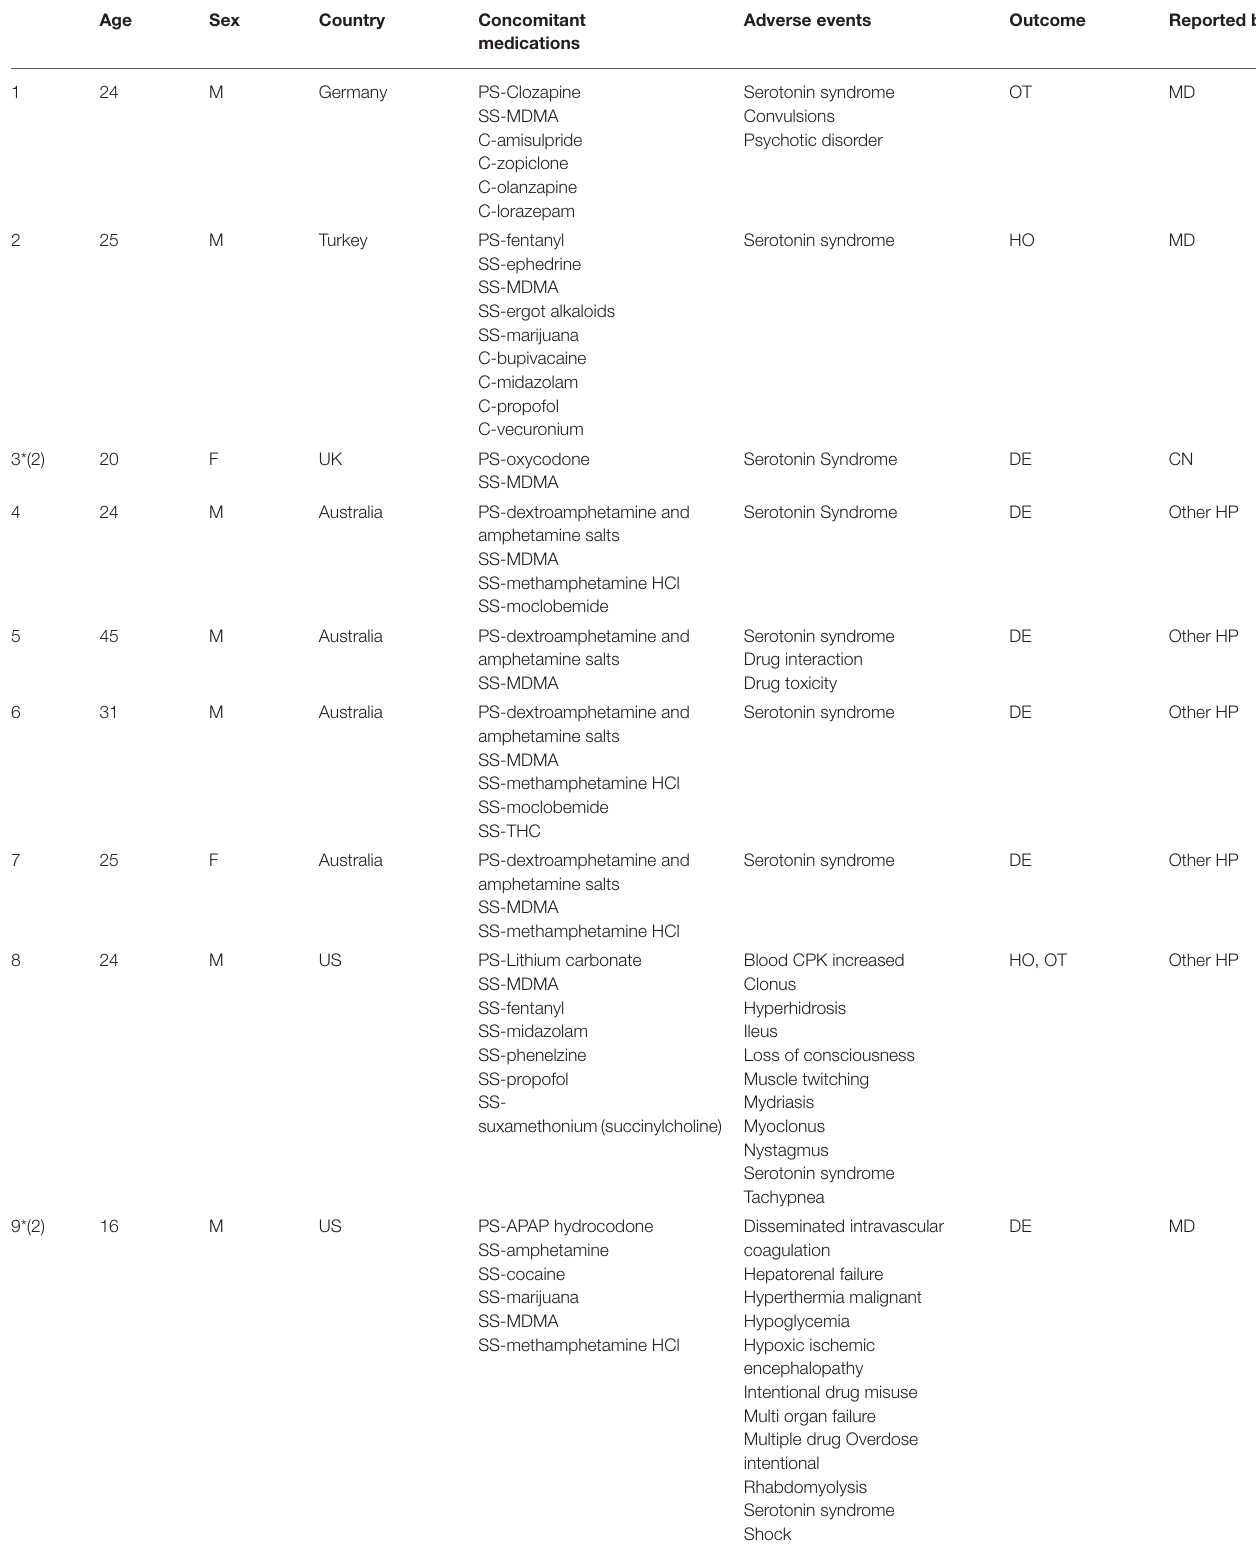
TABLE 1 | Individual cases of serotonin syndrome. Age Adverse events Outcome Reported